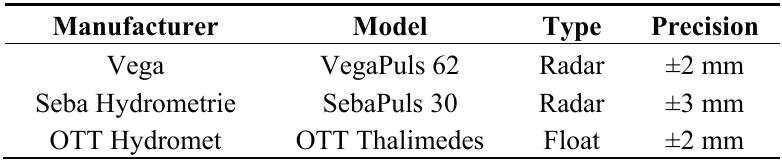
Table 3. Sensors used for tide